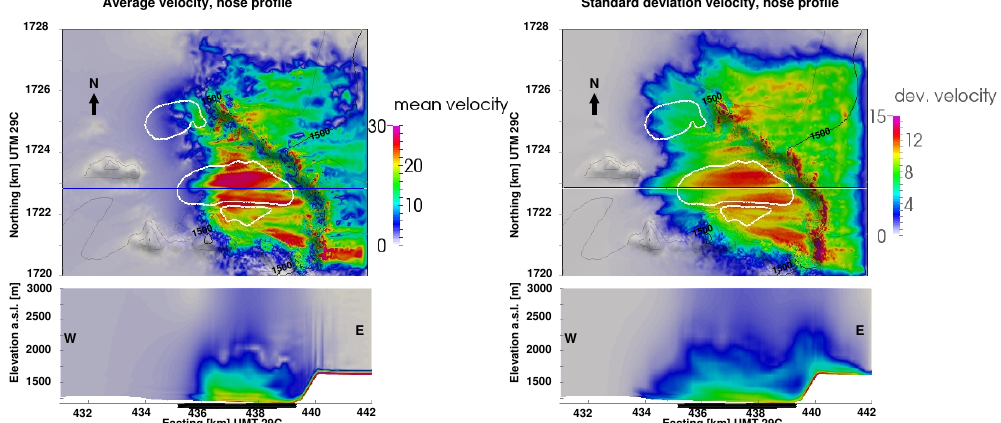
Figure 9. Statistics performed on the simulation using the nose profile (Eq. 5) using results from 950 to 1050s (in steps of 5s). The left panel shows the averaged velocity magnitude 5m above the surface and in a vertical cross section from east to west through the valley (marked by the horizontal blue line in plan views). The velocity scale is truncated at 30ms − 1 . The right panel shows the standard deviation from the average value of the velocity magnitude, which stands for a measure on the large-scale turbulence of the flow. This scale is truncated at 15ms − 1 . The cross sections are stretched vertically by a factor of